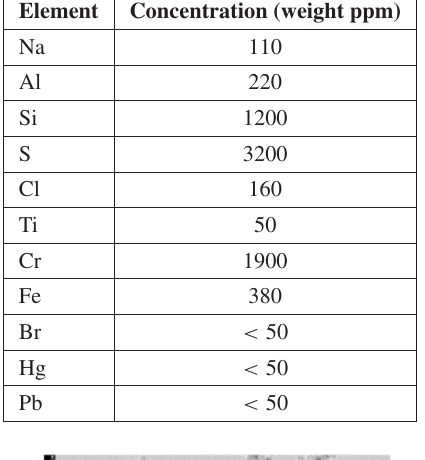
Table 2. Contaminations in DNPs measured by XRF.